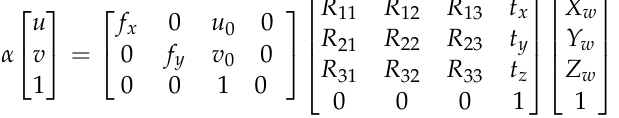
Figure 2. Coordinate system conversion.